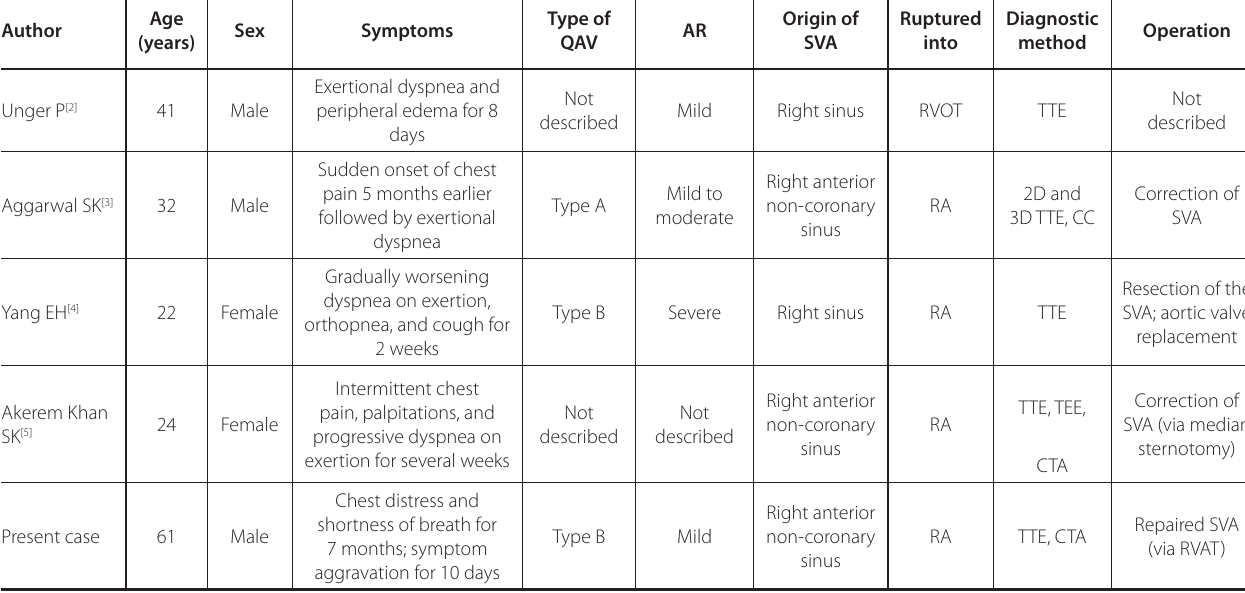
Table 1 . Summary of previously reported cases of QAV associated with ruptured SVA (including the present case).